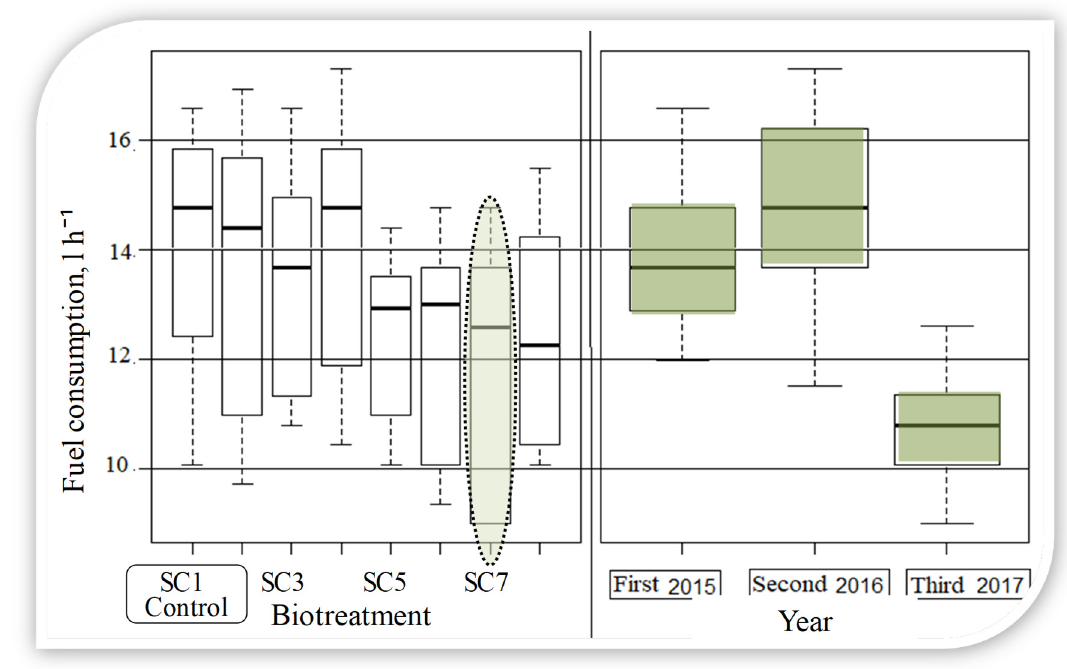
Figure 3. Ploughing fuel consumption (L h –1 ) dependence on bio-impact(s) time (year) and scenario.